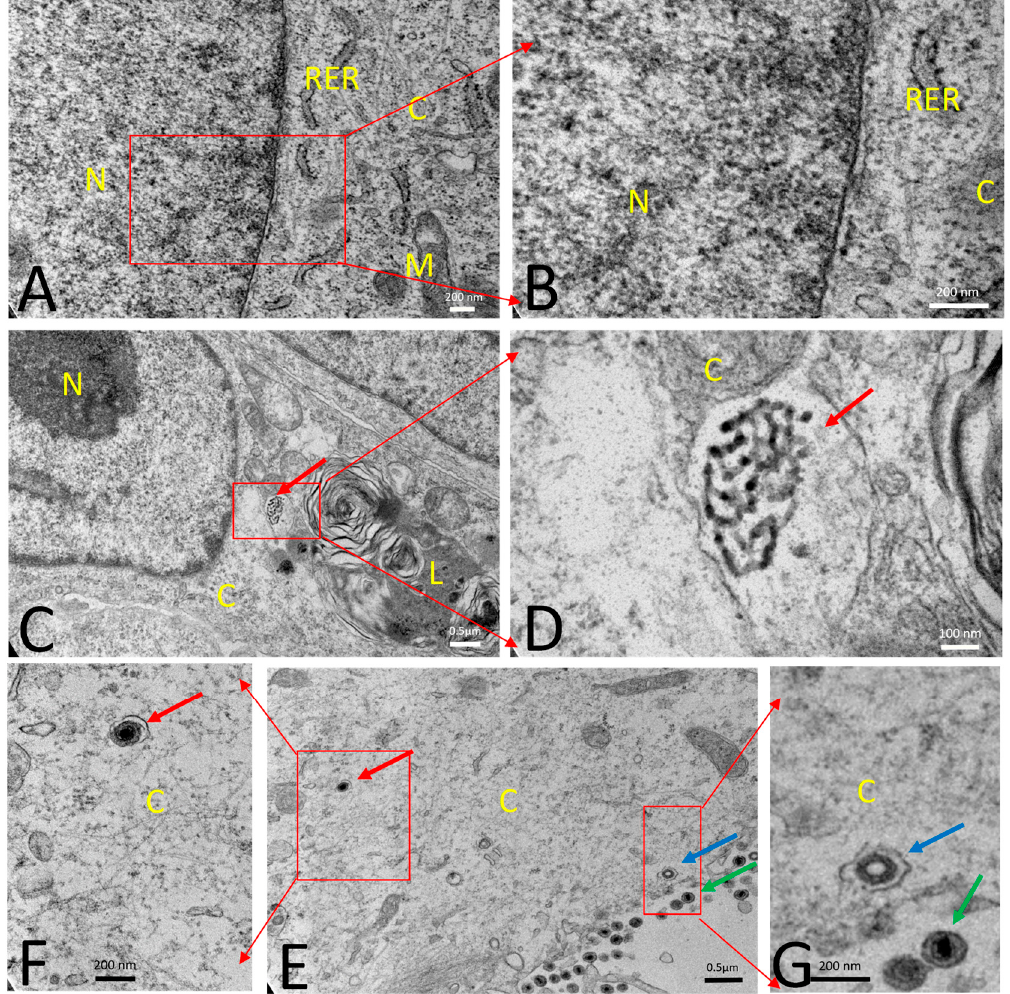
Figure 5. Transmission electron microscopy: ( A , B ) Mock infected healthy swine kidney (SK) cell with normal cellular morphology. ( C , D ) SK cells were infected with porcine circovirus type 2b (PCV2b) (infected at an MOI of 0.1) and fixed at 72 h post-infection (hpi). PCV2b infected cell showed accumulation of PCV2 viruses (red arrow) within the vesicle-like structures in the cytoplasm. Each PCV2 particle measured about 20 nm in diameter. ( E – G ) SK cells were infected with PRV wt (infected with an MOI of 5) and fixed at 12 hpi. PRV wt-infected cells showed enveloped herpesvirus (red arrow; about 200 nm in diameter) within the vesicle-like structure in the cytoplasm. The process of budding and release of several enveloped viruses were also noticed on the periphery of the cell near the plasma membrane (blue arrow). Released virus particles from the outer surface of the cells were accumulated in intercellular space (green arrow). ( B , D , F , G ) are magnifications of ( A , C , E ), respectively. N—Nucleus; C—Cytoplasm; RER—Rough endoplasmic reticulum; M—Mitochondria; L—Lysosomes.